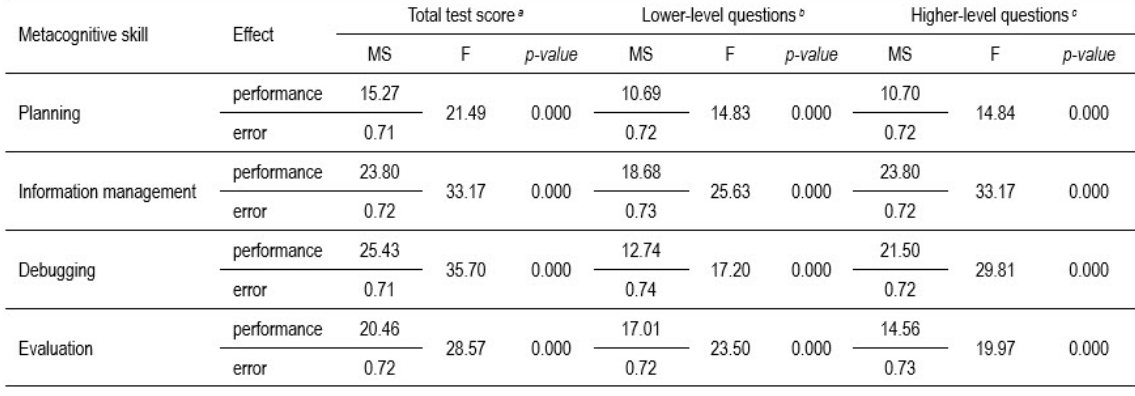
MANOVA results of between-subjects effects for metacognitive awareness perceptions and TIMSS- like total performance of Grade Nine (df=1,